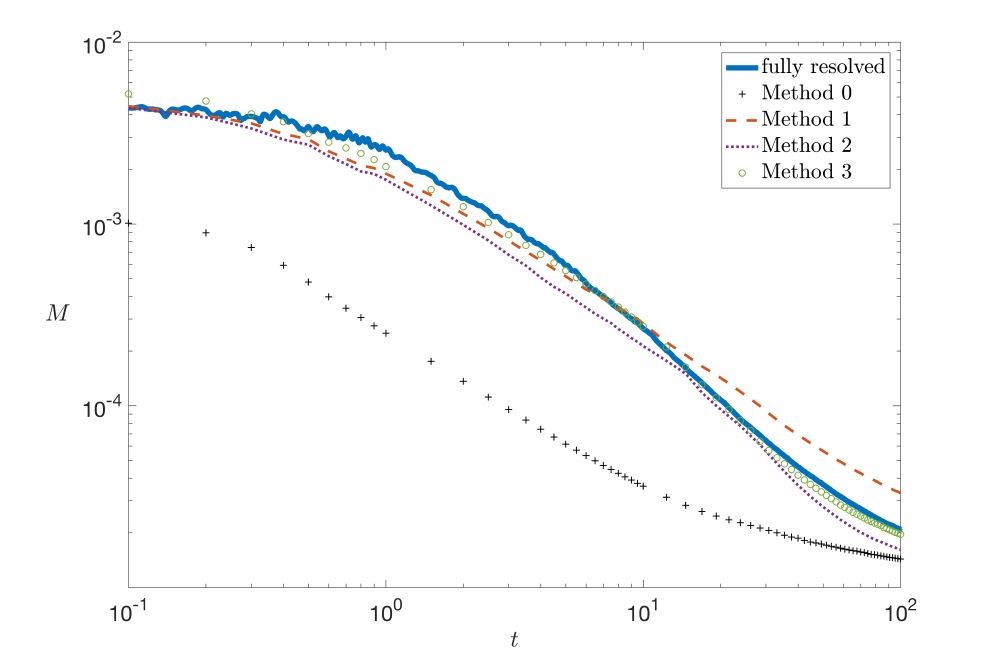
Figure 2. The integral of the squared concentration, M , versus time for the fully resolved random walk model and the different versions of the upscaled model described in Section 4.